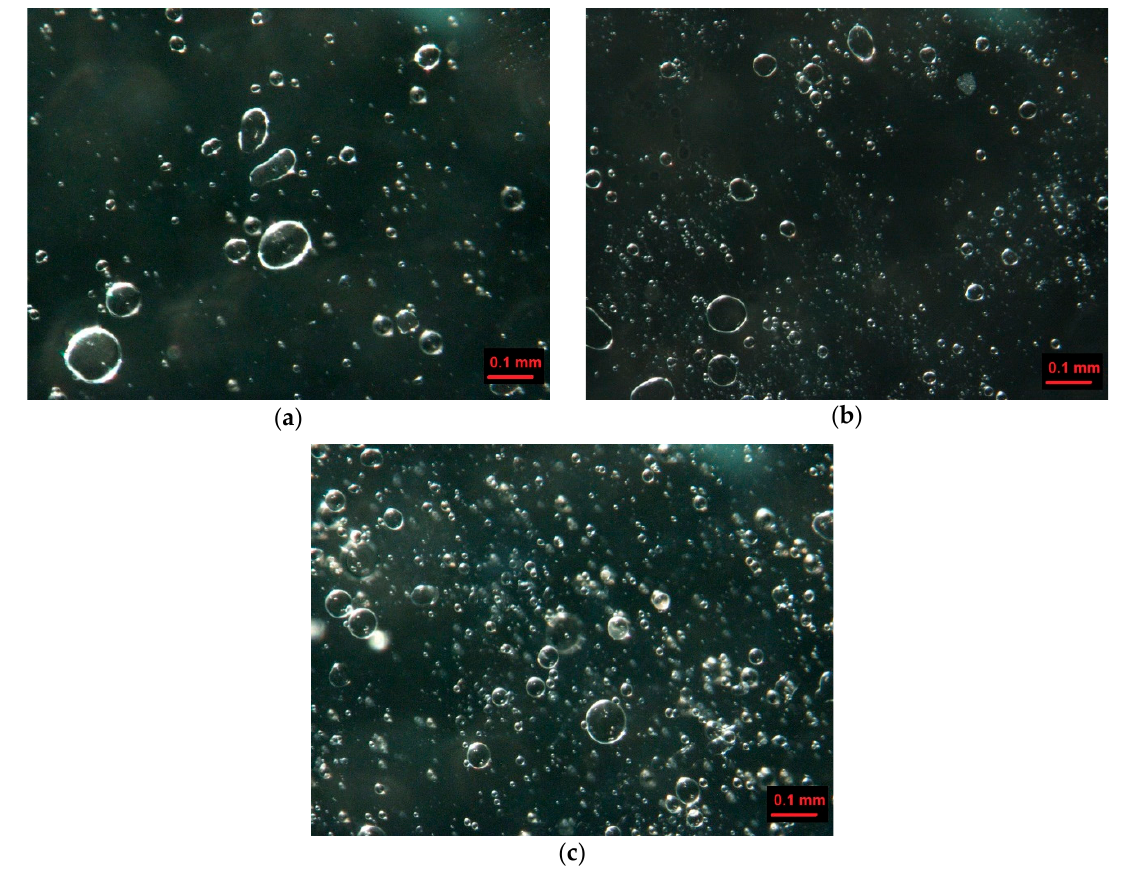
Figure 5. Structure of agar gel with oil prepared with different mixing rate: ( a ) 10,000, ( b ) 11,000, ( c ) 13,000 rpm.